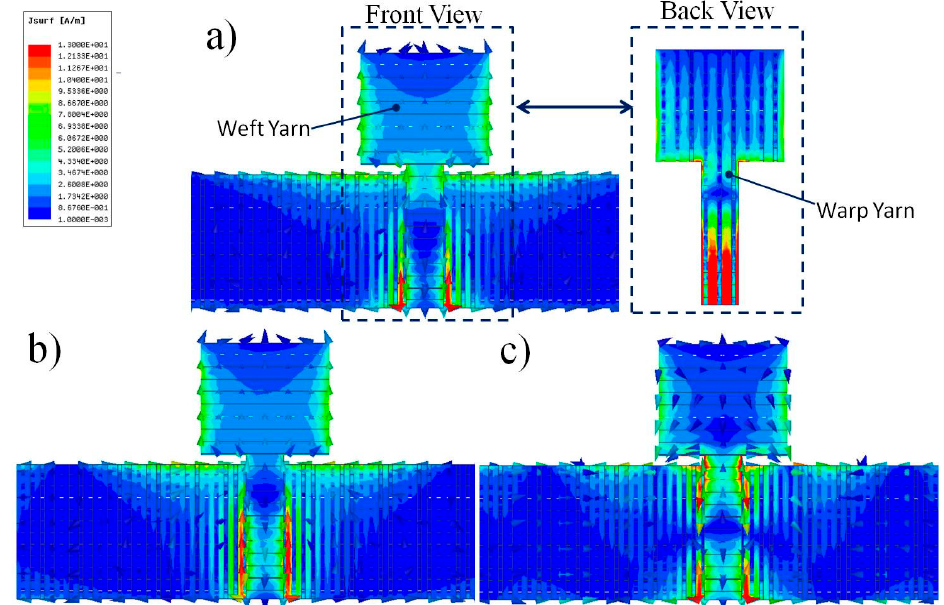
Figure 5. Simulated antenna current distribution: ( a ) 4 GHz; ( b ) 5 GHz; and ( c ) 8 GHz. The values correspond to the case when the antenna accepts 1 W of power.